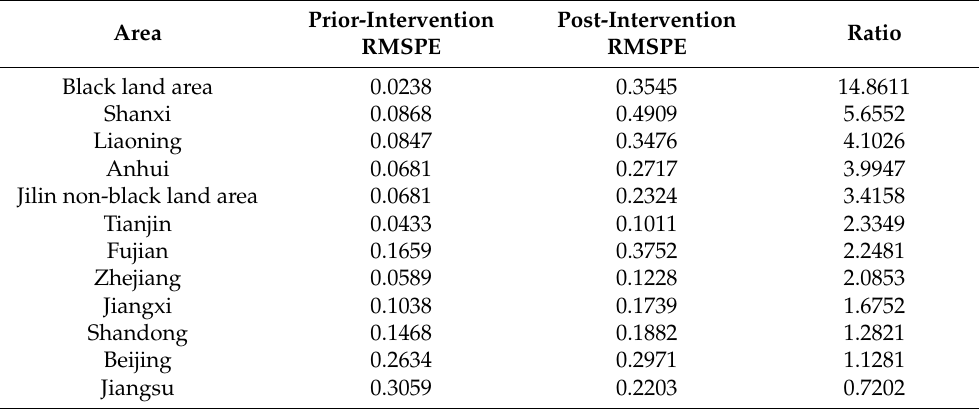
Table 4. Post/prior-RMSPE ratios for industrial wastewater discharges in the black land area and the control regions. Prior-Intervention Post-Intervention Area RMSPE RMSPE Black land area